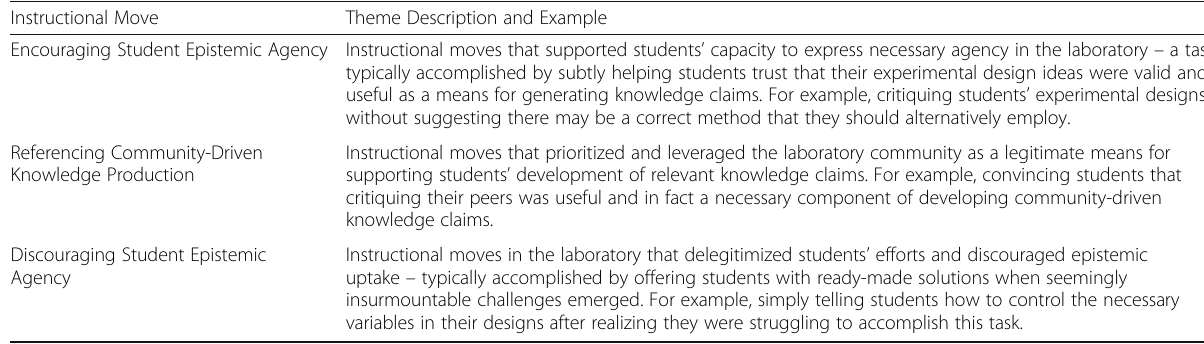
Table 3 Summary of the instructional moves observed in the laboratory Instructional Move Theme Description and